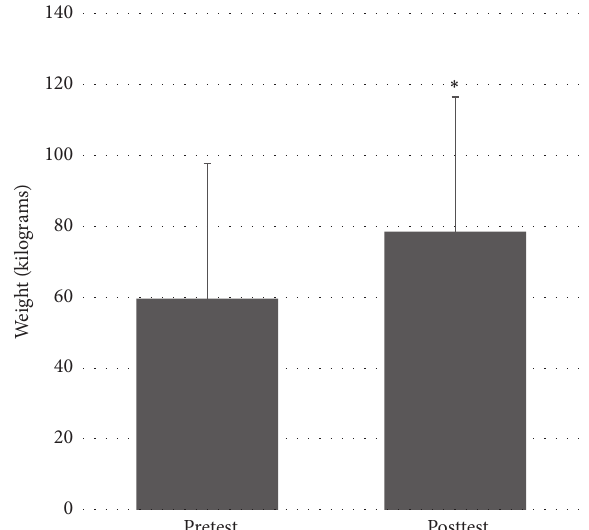
Figure 1: Pretest and posttest values for right leg 1RM. ∗ denotes statistically significant difference at 𝑃 < 0.05 .